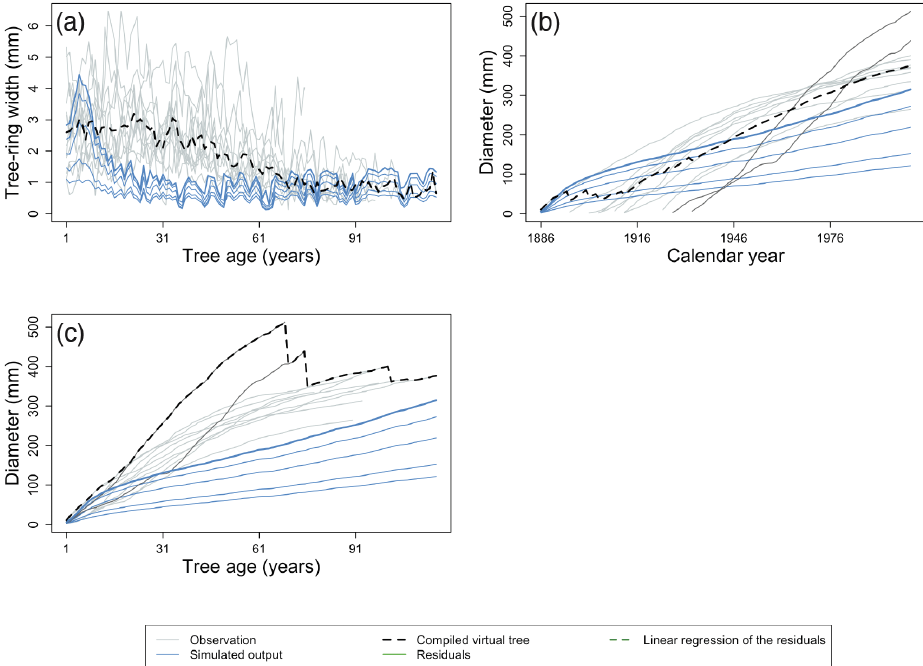
Figure 4. Using virtual trees to account for challenges related to the use of ITRDB datasets when evaluating land surface. (a) Data–model comparison may overcome the big-tree selection bias by comparing only the simulated largest diameter class (bold blue line) for evaluation rather than all diameter classes (thin blue lines), with the compiled average virtual tree (black dotted line). Grey lines represent individual trees from observations. (b) The observed tree-ring records are a mixture of relatively slow-growing trees (light grey lines) and fast-growing trees (dark grey lines). Fast-growing trees do not attain the same age as slow-growing trees because they tend to die earlier. Using all trees without further consideration in the calculation of the average virtual tree (black dotted line) would lead to an underestimation of tree growth at the time of stand establishment, resulting in a flawed comparison with the simulated tree growth (blue lines). (c) However, aligning observations by the age of individual trees before compiling the largest virtual tree (black dotted line) results in a very different virtual tree compared with Fig. 4b. The largest virtual tree better reconstructs tree growth during stand establishment, thereby facilitating data–model comparison. Note the change in the x axis label between panels (b) and (c) . Observations taken from a pine forest in Germany, archived as germ214 (Neuwirth et al., 2007) (Table S3). Simulation were run with ORCHIDEE